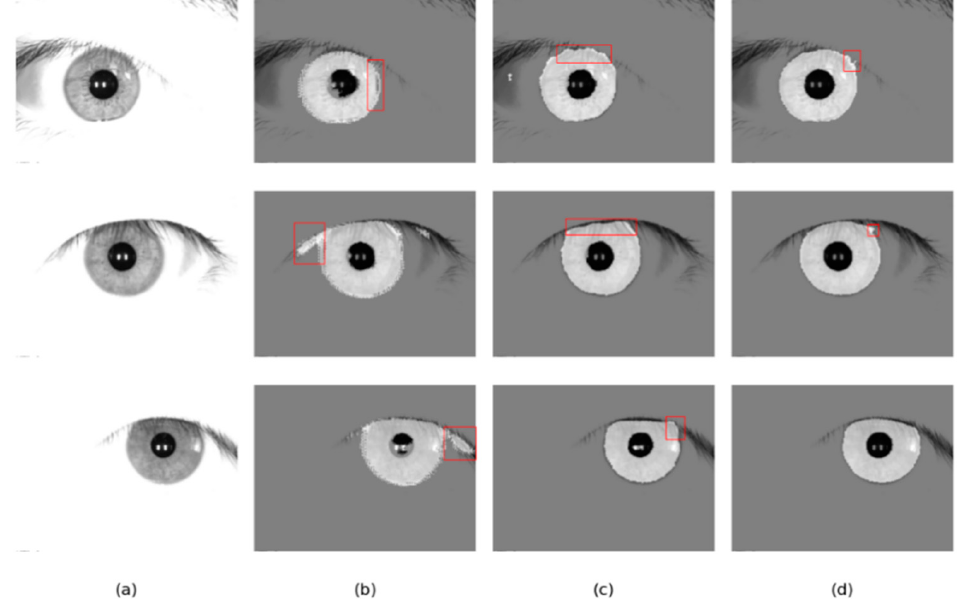
Figure 15. Segmentation results of different methods on the JLU-4.0 database: ( a ) Original image, ( b ) results of Linknet, ( c ) results of DMS-UNet, and ( d ) results of the proposed network.